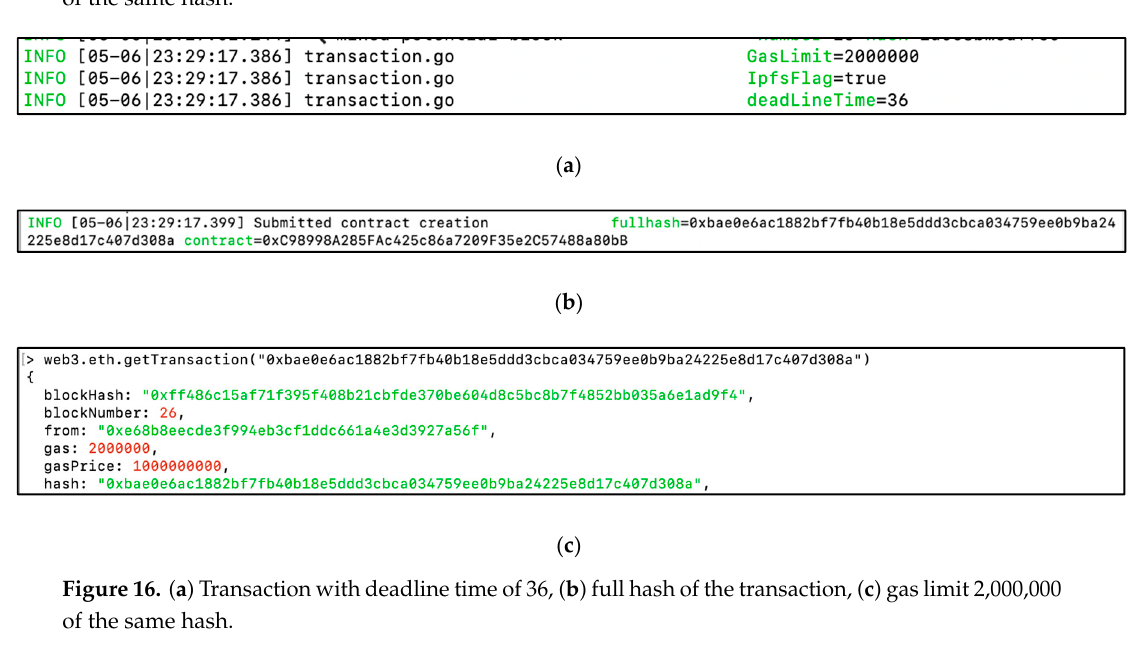
Figure 15. ( a ) Transaction with deadline time of 35, ( b ) full hash of the transaction, ( c ) gas limit 3,000,000 of the same hash.